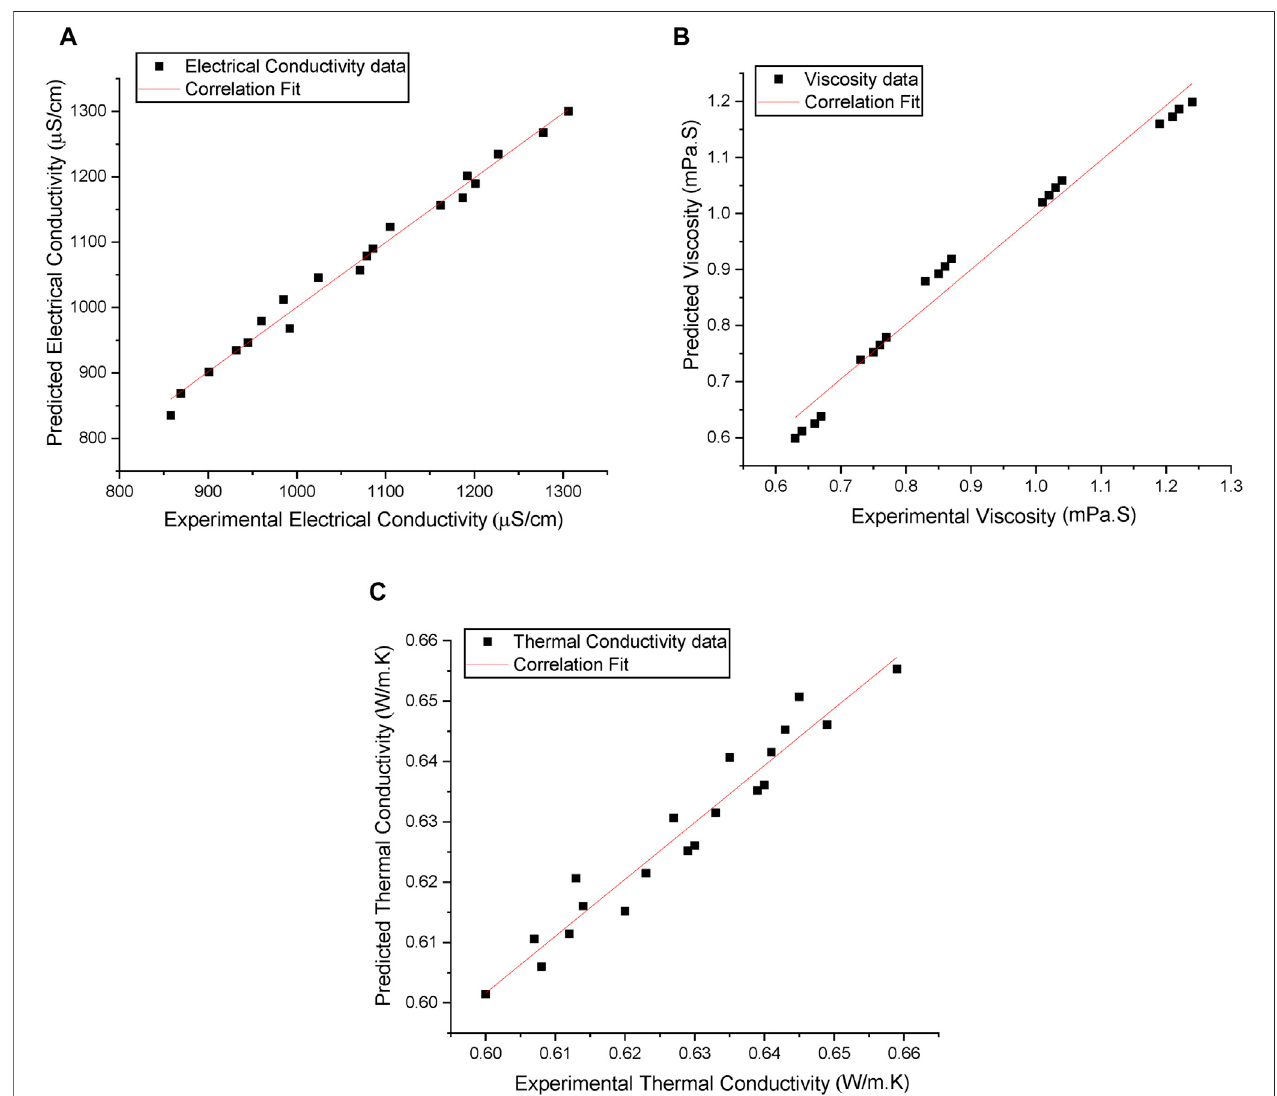
FIGURE 8 | Variation of (A) predicted electrical conductivity with experimental electrical conductivity, (B) predicted viscosity with experimental viscosity, and (C) predicted thermal conductivity with experimental thermal conductivity.